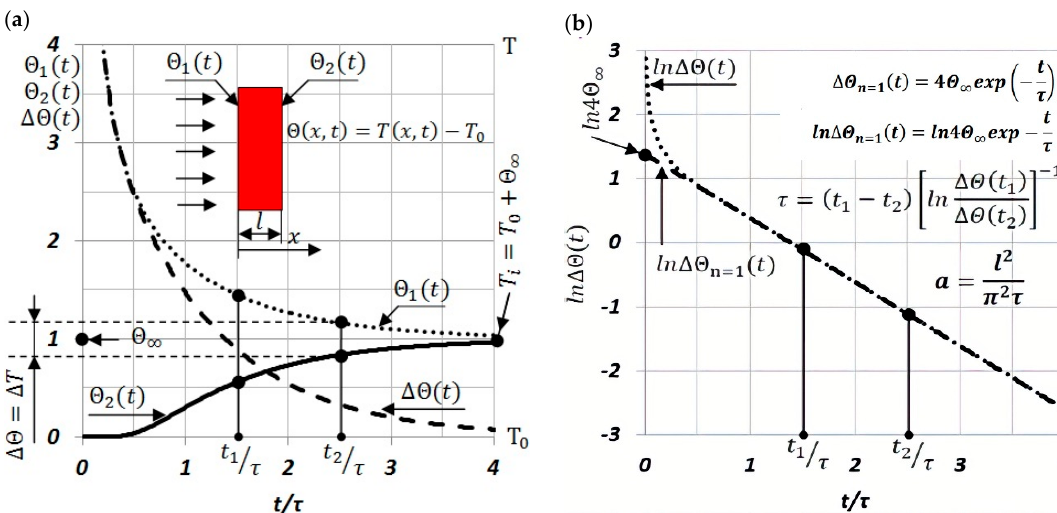
Figure 1. Rule for determining the thermal diffusivity of a sample using modified-pulse method (MPM). ( a ) Temperature changes on opposite surfaces of the sample; ( b ) procedure for determining characteristic time and thermal diffusivity.